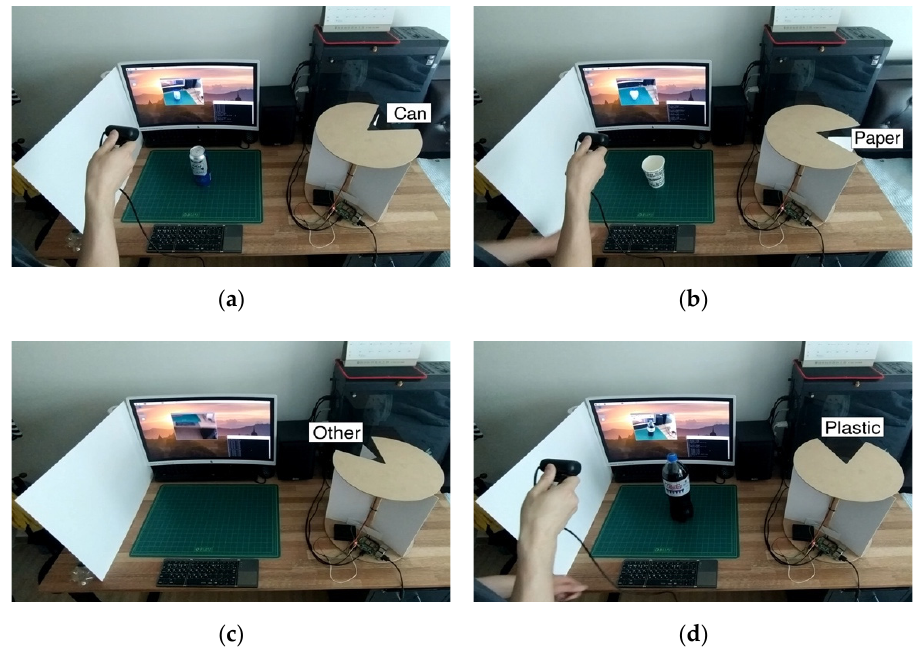
Figure 10. System integration testing with can ( a ), paper ( b ), other ( c ), and plastic ( d ) as recyclables.